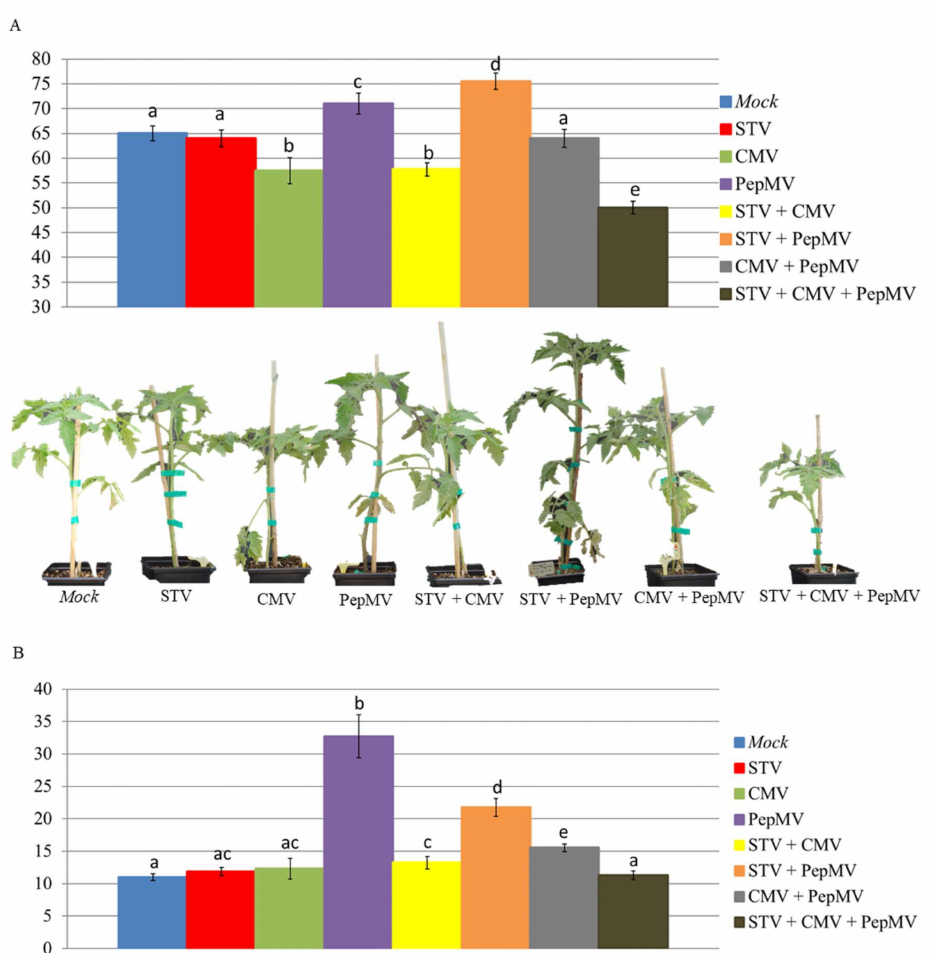
Figure 3. Graphical representation (mean values) of height (Panel A ) and weight (Panel B ) measured in cm and g, respectively, of tomato plants infected with STV, PepMV, and CMV in single and mixed infections at 20 dpi. Bars and letters up to the columns correspond to standard errors and different plant groups ( p -value ≤ 0.05), respectively. At the bottom of (Panel A ), we show the height of tomato plants infected with different virus combinations in comparison with mock-inoculated